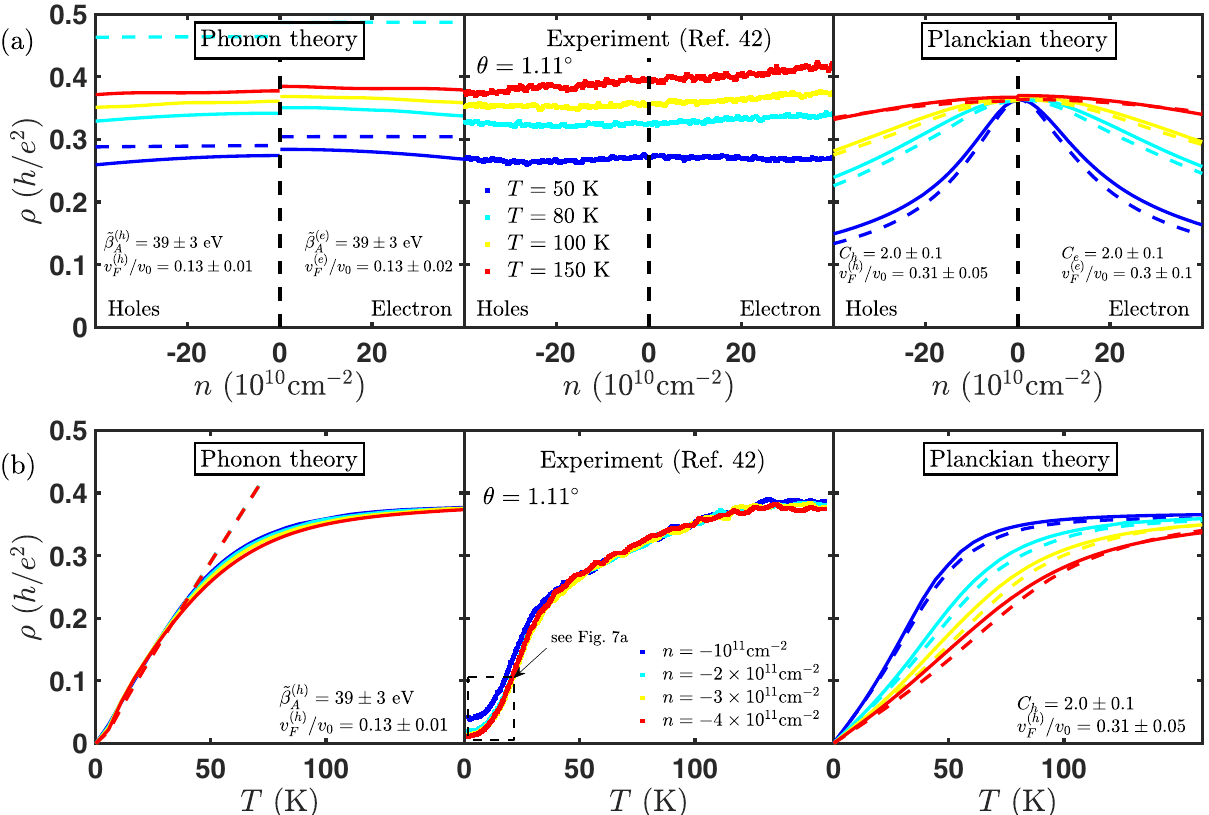
Fig. 2 Experimental observations are consistent with the electron-phonon scattering theory. The electron – phonon scattering theory (left panels) correctly captures the a carrier density and b temperature dependence of experimentally observed resistivity (middle panels), unlike the Planckian theory (right panel) that shows a stronger density dependence. Experimental data is taken from ref. 42 for θ = 1.11 ∘ (comparison for devices with other twist angles is shown in the Supplementary Information). Solid lines in the electron – phonon and Planckian theory are for a two-band effective model that includes the van Hove singularity, while the dashed lines are for the linear Dirac model. For electron – phonon scattering, the linear-in- T resistivity at low temperature is captured by the Dirac model, while the saturation at higher temperature requires the van Hove singularity. For the Planckian theory, the Dirac model and the two-band model are quantitatively similar and show much stronger density dependence compared to the experiment. In this case, the saturation at high temperature is set not by the van Hove singularity, but by a universal value ρ ð T ! 1Þ ¼ C = ð 8ln2 Þ h = e 2 (the coef fi cient C ≤ 1 for Planckian dissipation). For most experimental data, including those shown here, C ≥ 1. Taken together with the weak density dependence seen experimentally, this suggests that phonon scattering rather than Planckian dissipation is the dominant scattering mechanism at play in twisted bilayer